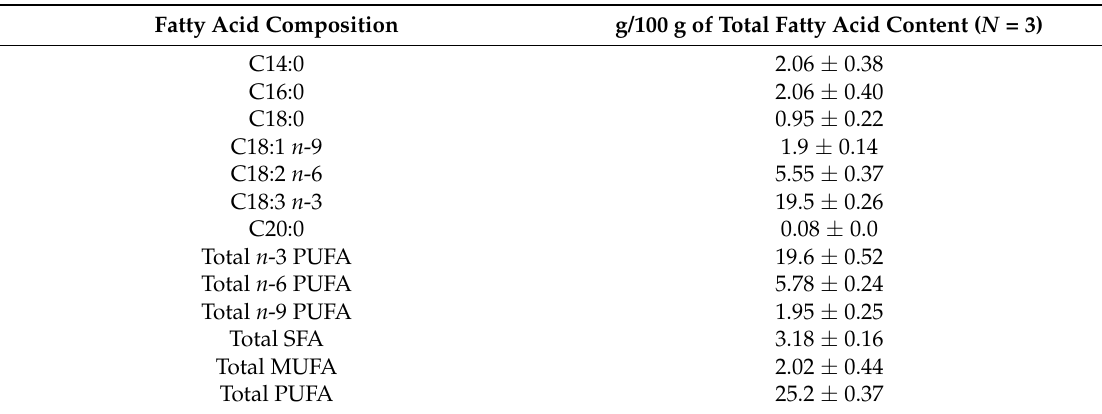
Table 1. Fatty acid profile of chia